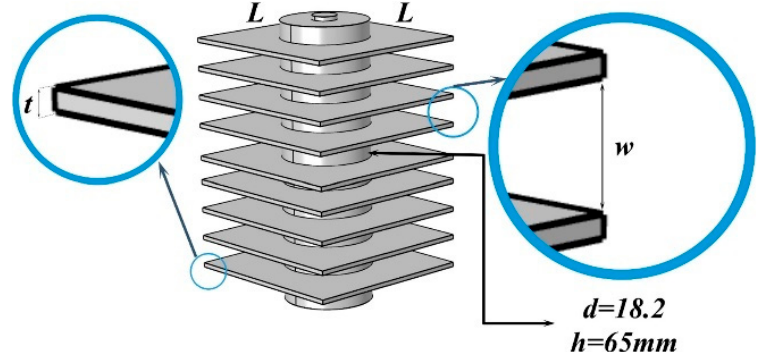
Figure 18. The PCM-fins BTMS considered in [68]. Reproduced with permission from